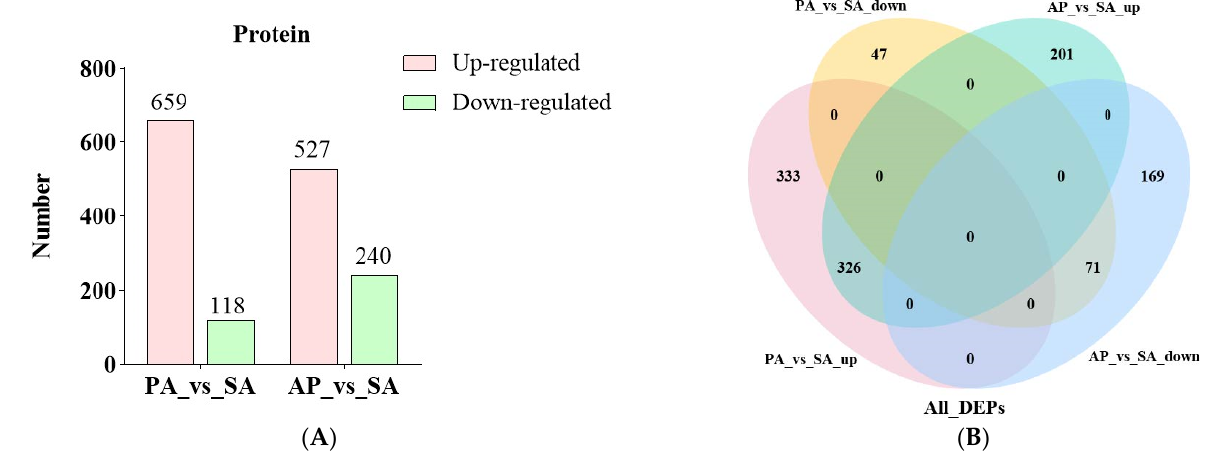
Figure 3. Statistics and Venn diagrams of differentially expressed proteins (DEPs) in all samples. ( A ) Statistics diagrams of DEPs; ( B ) Venn diagrams of DEPs.